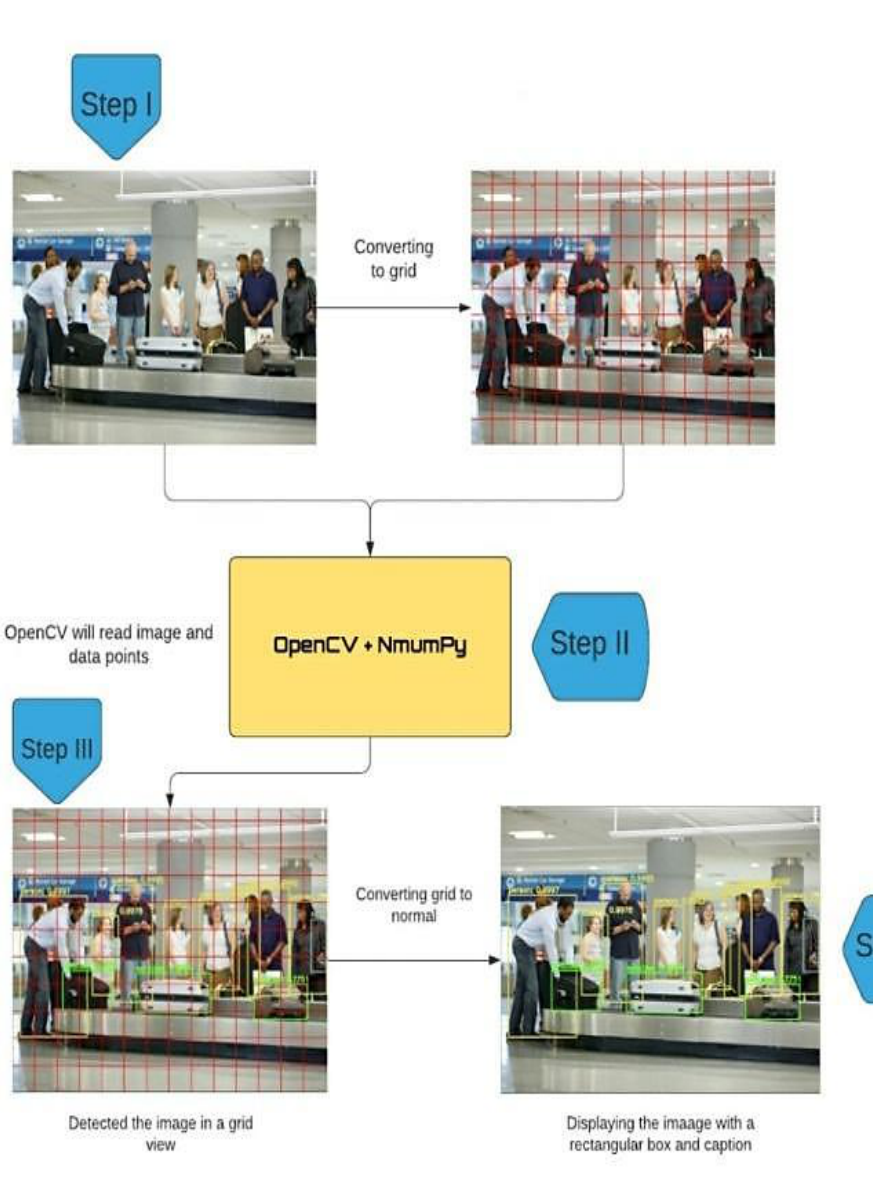
Figure 7. Flowchart of the proposed algorithm